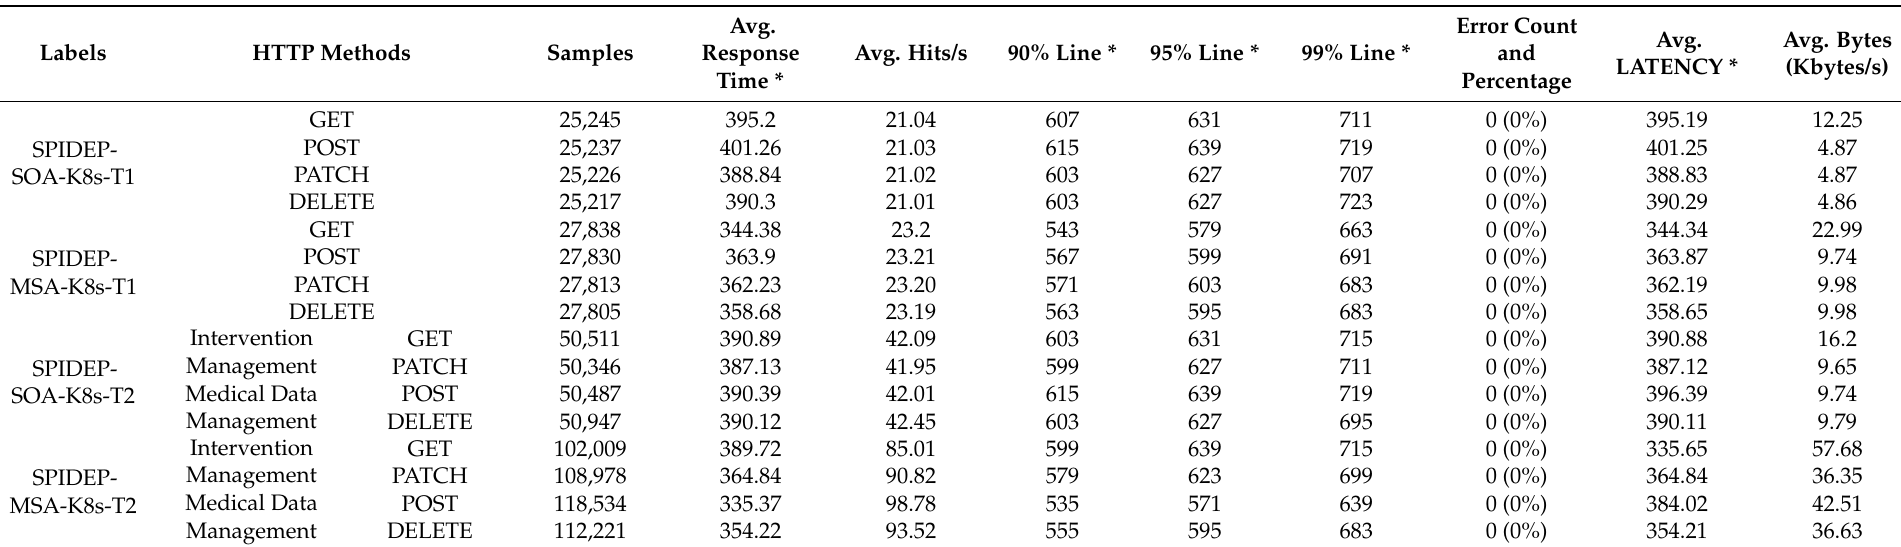
Table 3. General results of the simultaneous queries made to the RESTful methods of the SPIDEP application, under the SOA and MSA architectural styles, invoking single and dual services (i.e., medical data management (service E) and intervention management (service